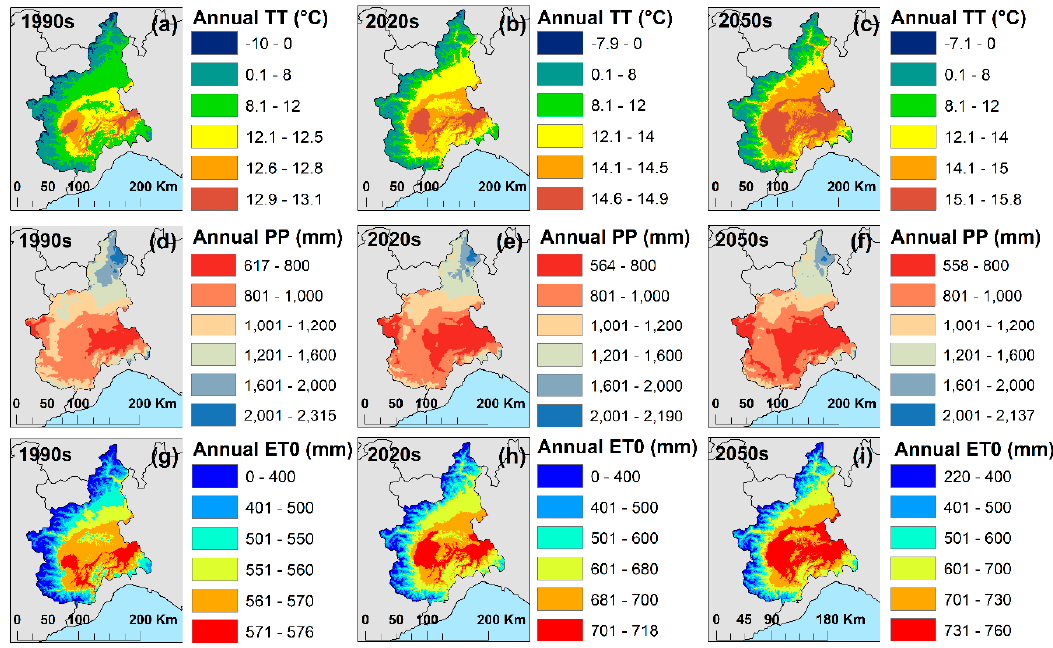
Figure 2. Spatial distribution of temperature, precipitation, and potential evapotranspiration (ET0) in the Piedmont region. ( a ) The average of the mean annual air temperature between 1960 and 1990 (1990s); ( b ) The average of the mean annual air temperature between 2011 and 2040 (2020s); ( c ) The average